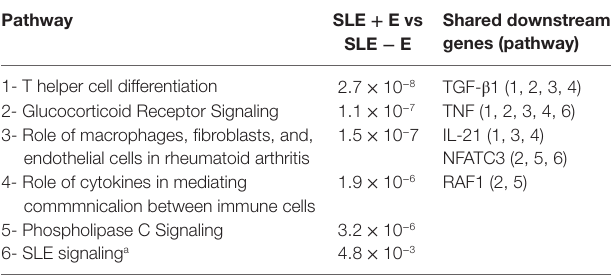
TaBle 2 | The top five canonical signal transduction pathways affected by estradiol in activated systemic lupus erythematosus (SLE) T cells. Pathway